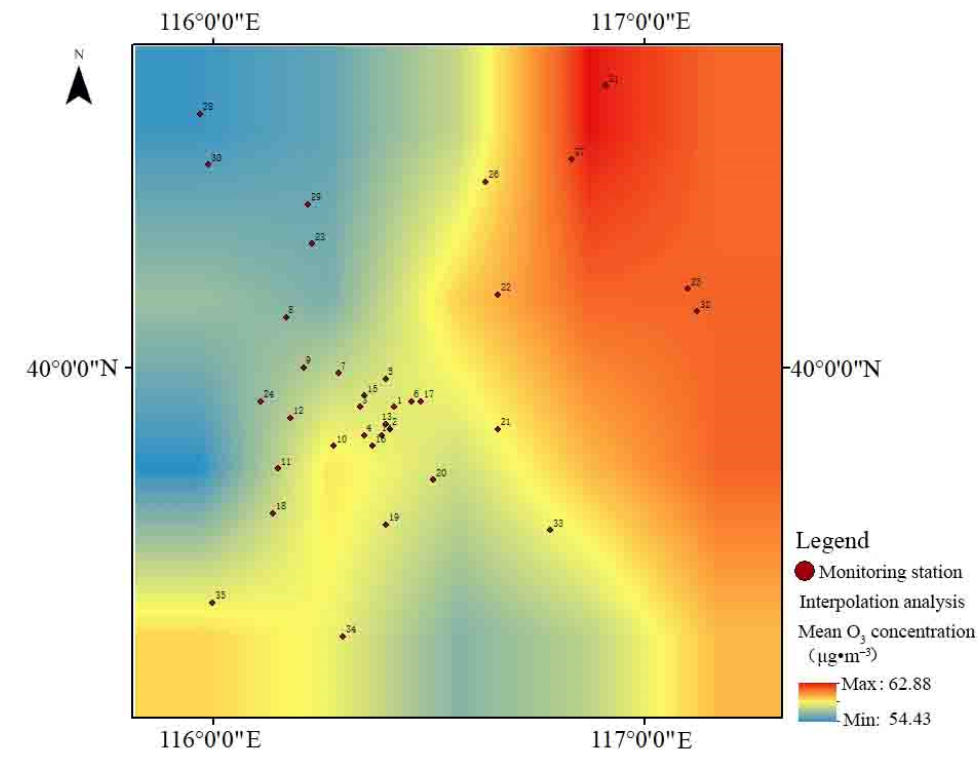
Figure 6. Interpolated (Krigging) contoured surface of annual mean O 3 concentrations in Beijing in 2020. Table 2. Regional distribution of average seasonal and annual average O 3 concentrations ( µ g · m − 3 ).